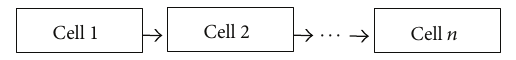
Figure 1: A Schematic view of the cells in the proposed plan